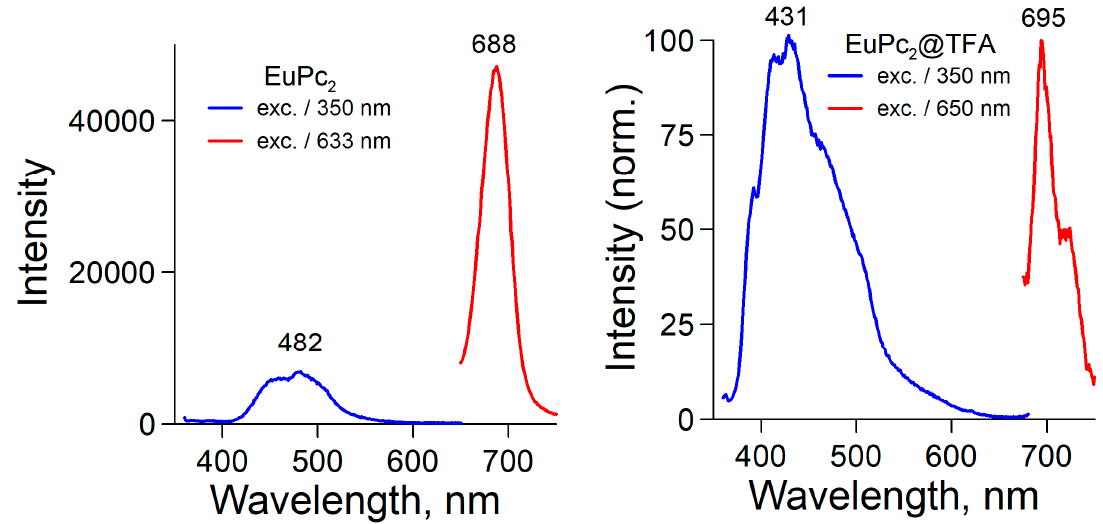
Figure 6. Fluorescence emission spectra of the base EuPc 2 complex ( left ) and its TFA-conjugate ( right ) in benzene solution.